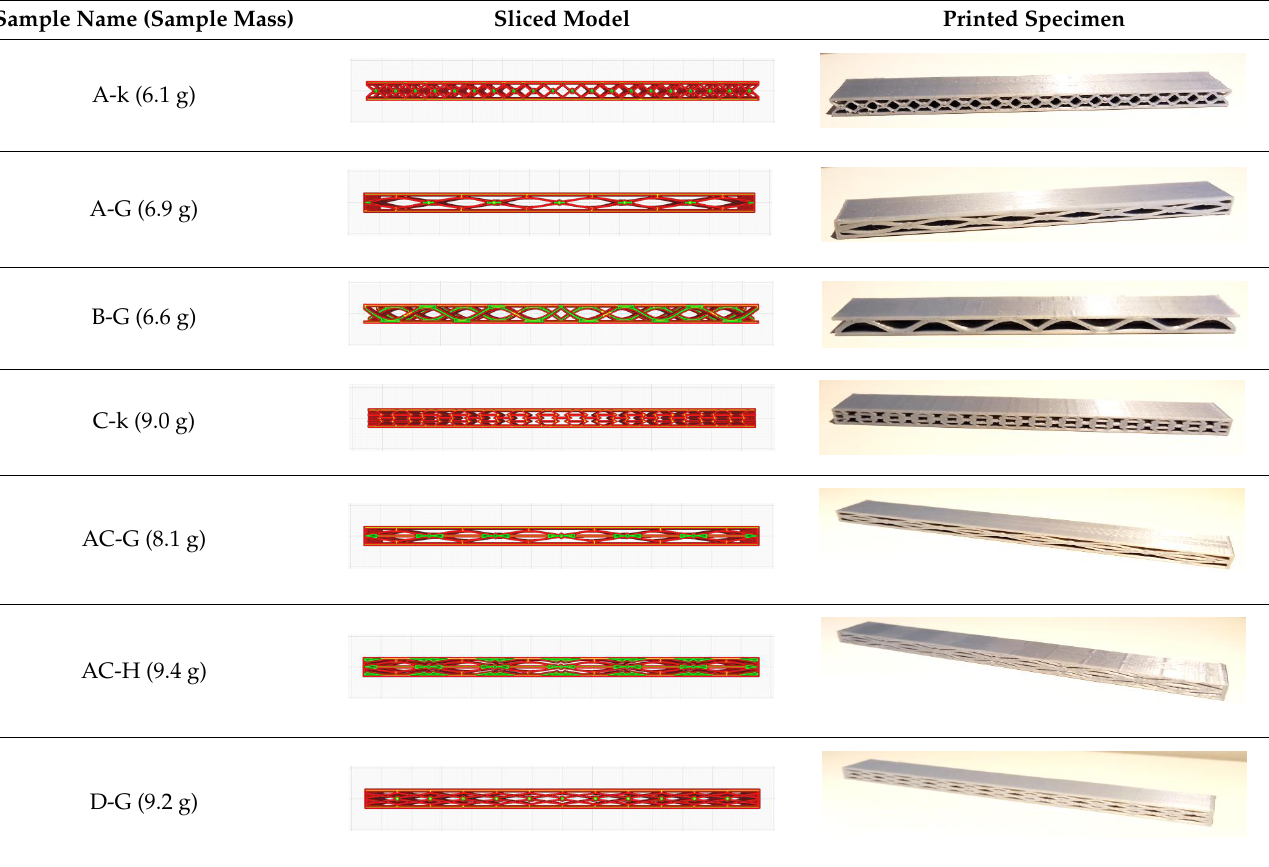
Table 1. Samples used in this study. Red parts denote the printed shell, the green parts show the printed inner wall (all samples were printed without support structures).